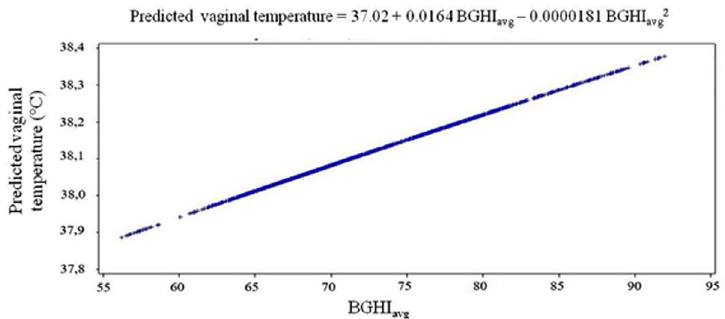
Fig 5. Vaginal temperature of Nellore heifers as a function of the average black globe temperature and humidity index (BGHI) of systems with different microclimatic conditions.